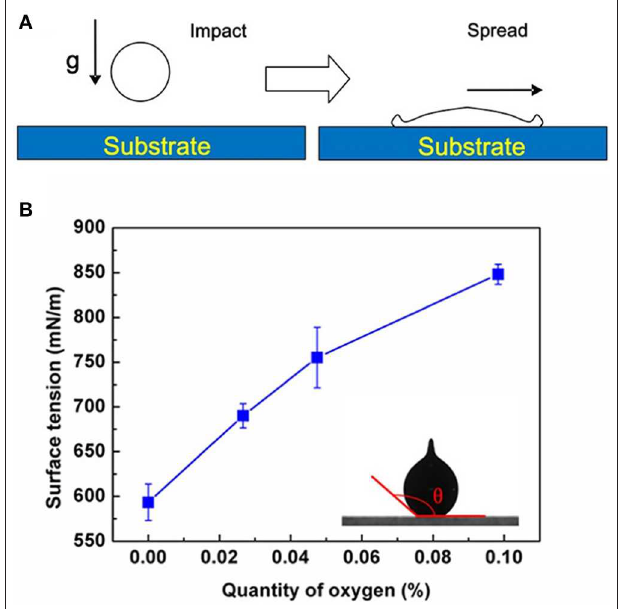
FIGURE 3 | Impact and spread processes of a single droplet on a flat substrate surface (A) , and the relation curve between the surface tension of liquid metal and the quantity of oxygen (B) . The inset represents a schematic diagram of the contact angle of a liquid metal droplet. Reproduced with permissions from Zhang et al. (2013). Copyright 2013, Springer Nature.